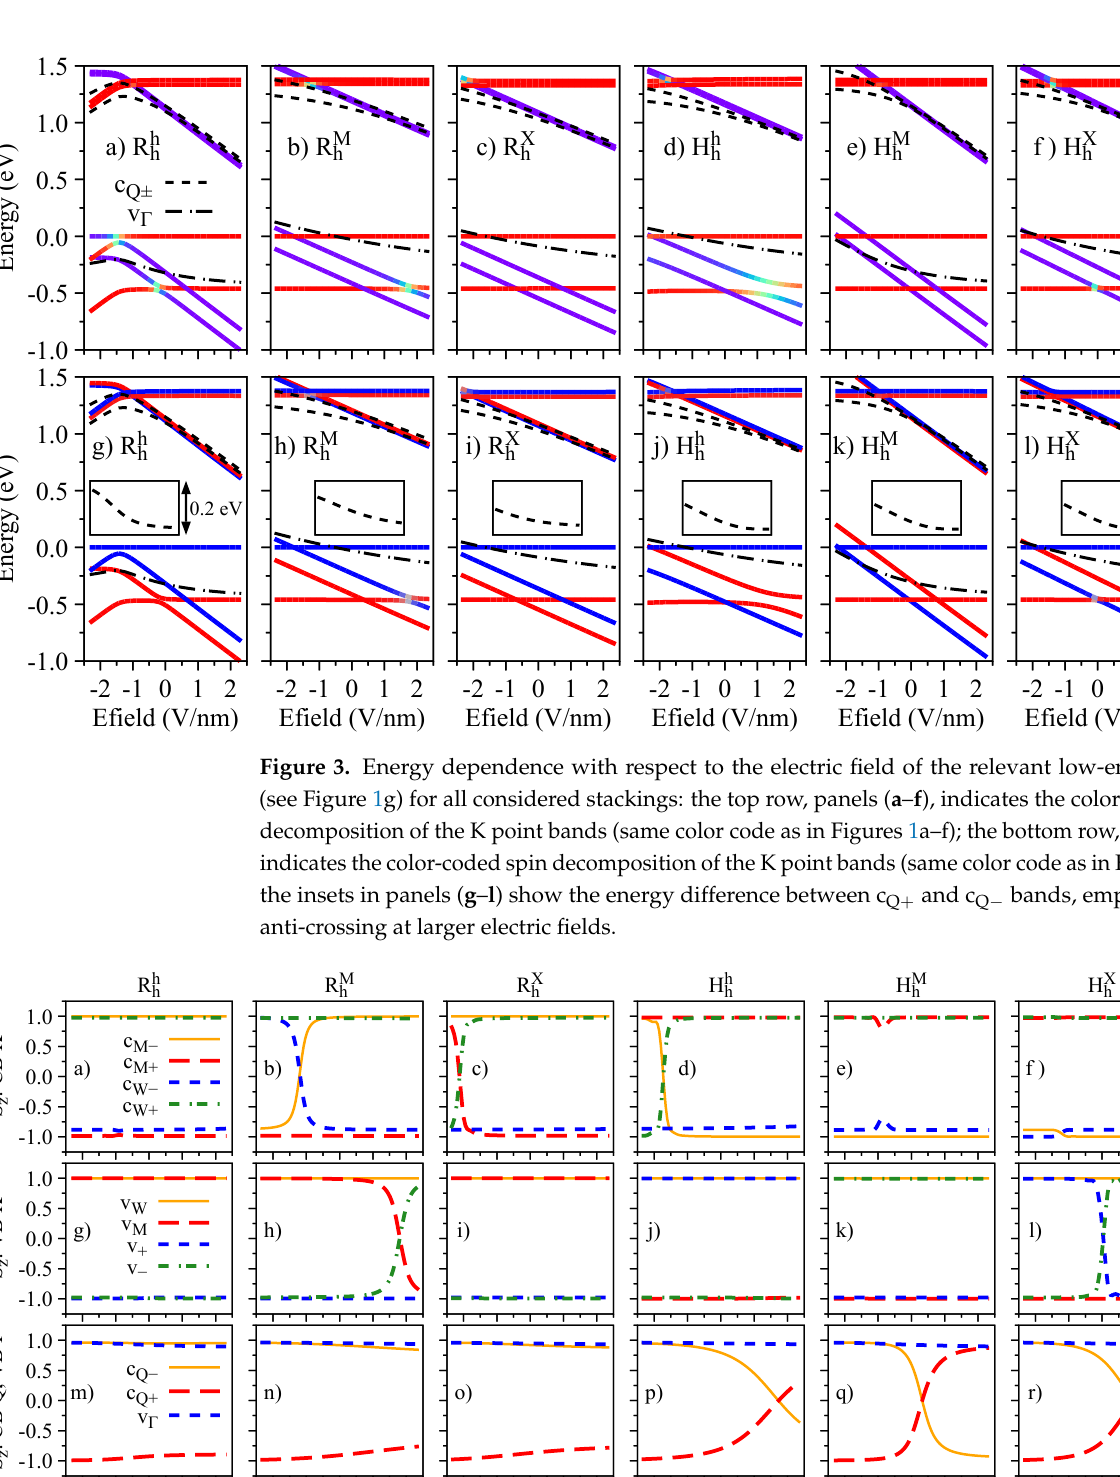
( a , g , m ), R M ( b , h , n ), R X ( c , i , o ), H h ( d , j , p ), H M ( e , k , q ), and H X ( f , l , r h h h h h h